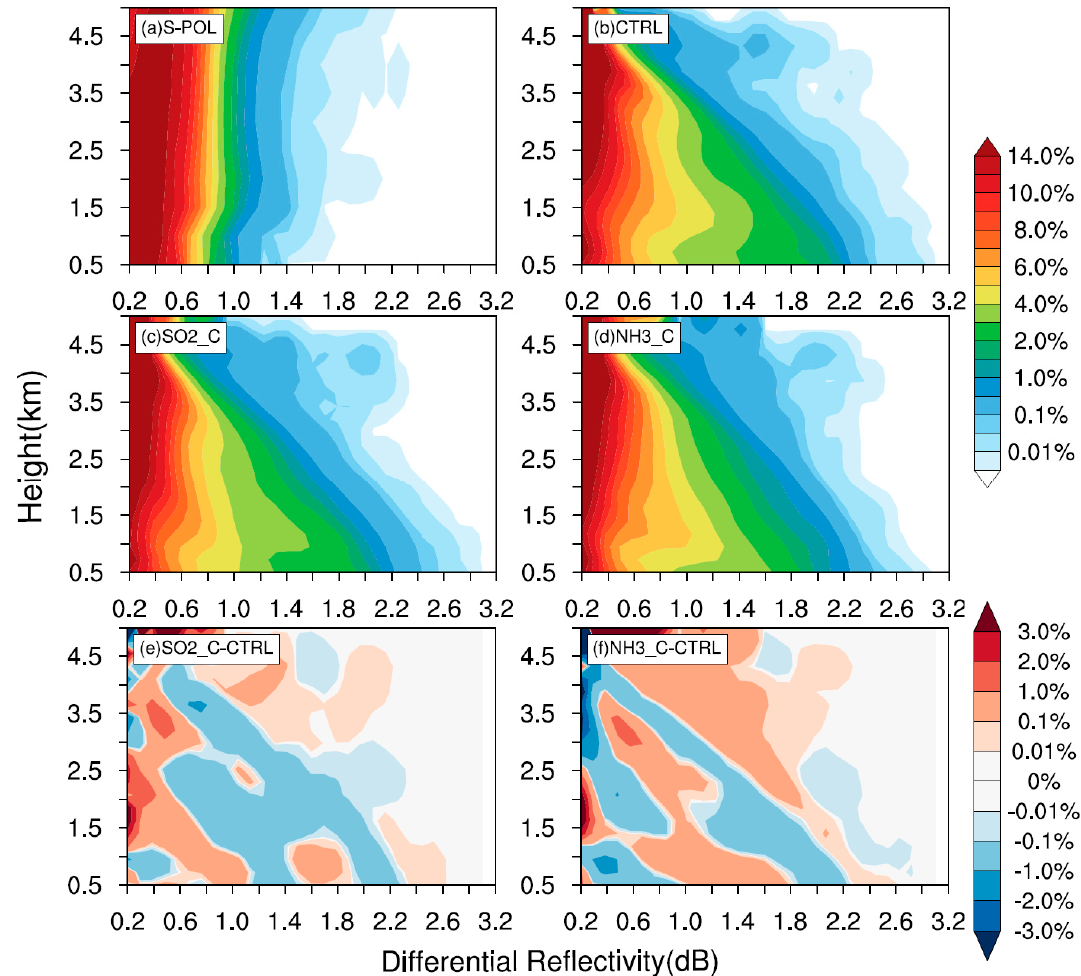
Figure 5. The contoured frequency by altitude diagram of differential reflectivity (dB) from ( a ) S-band polarimetric radar, ( b ) CTRL, ( c ) SO2_C, ( d ) NH3_C, ( e ) differences between SO2_C and CTRL, and ( f ) differences between NH3_C and CTRL runs. The data at 0200 UTC and 0300 UTC 2 August within the black solid square in Figure 4b are involved for analysis.